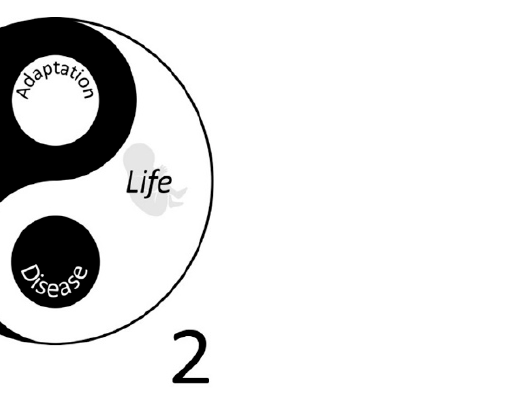
Figure 1. A new symbol for oxygen that reflects its Yin and Yang. In the new symbol, the chemical symbol of Oxygen is merged with the Taiji symbol.